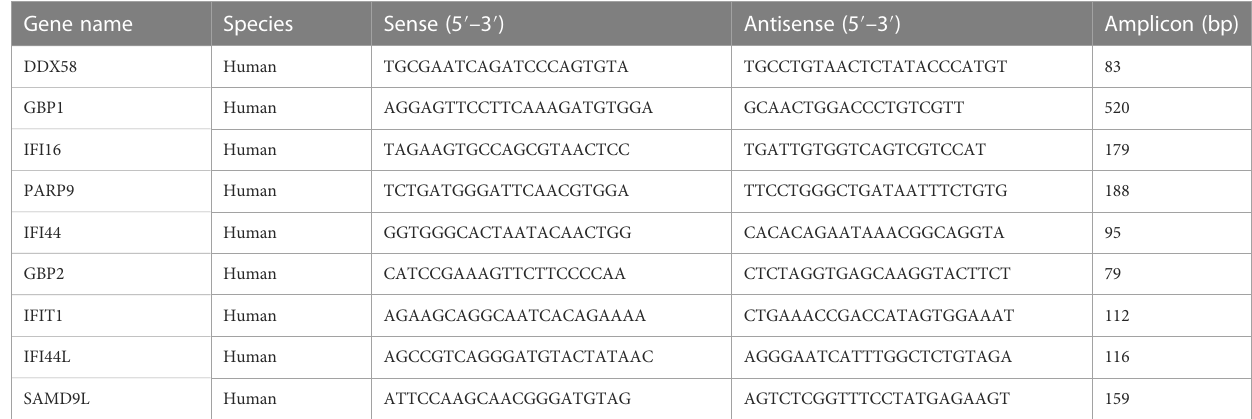
TABLE 2 Primer sequences for